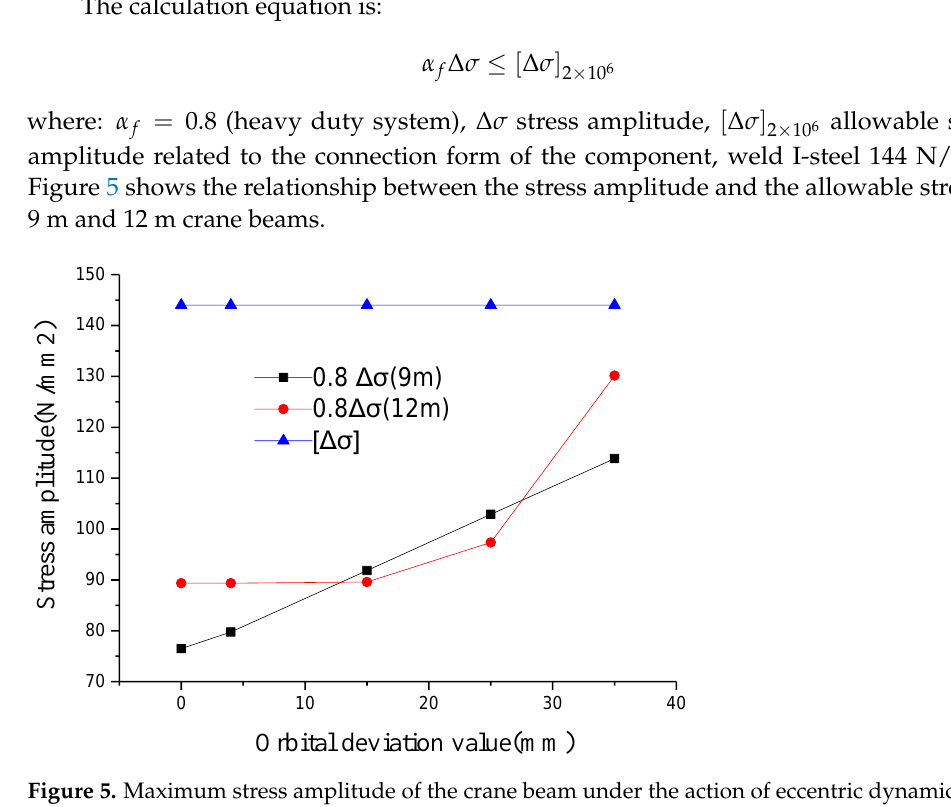
Figure 5. Maximum stress amplitude of the crane beam under the action of eccentric dynamic load.